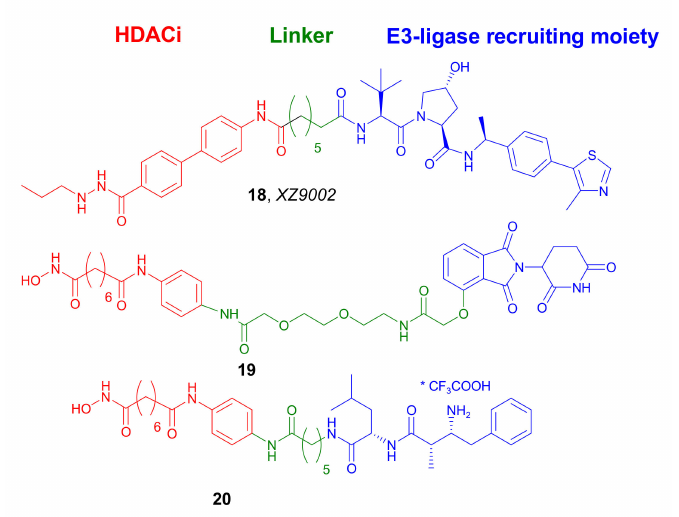
Figure 10. Chemical structure of PROTACs 18 – 20